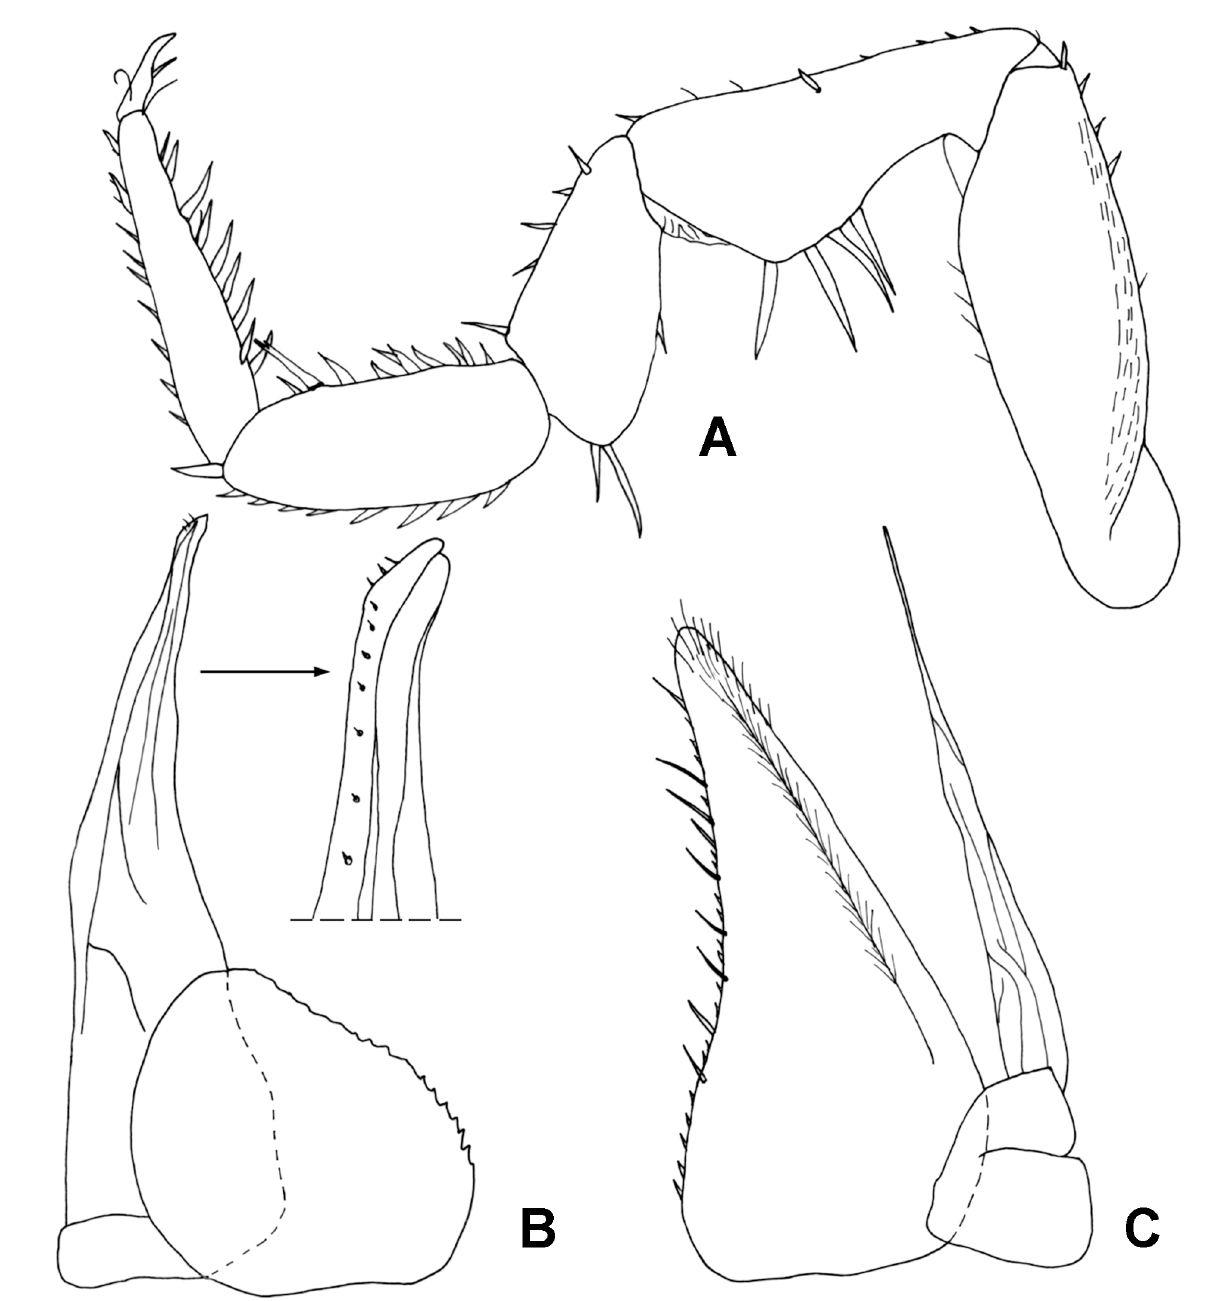
Fig. 27. Trichorhina anophthalma Ancangeli, 1935 from Algar de Santo António, Estremoz-Cano, ♂. A . Pereopod 7. B . Pleopod 1. C . Pleopod